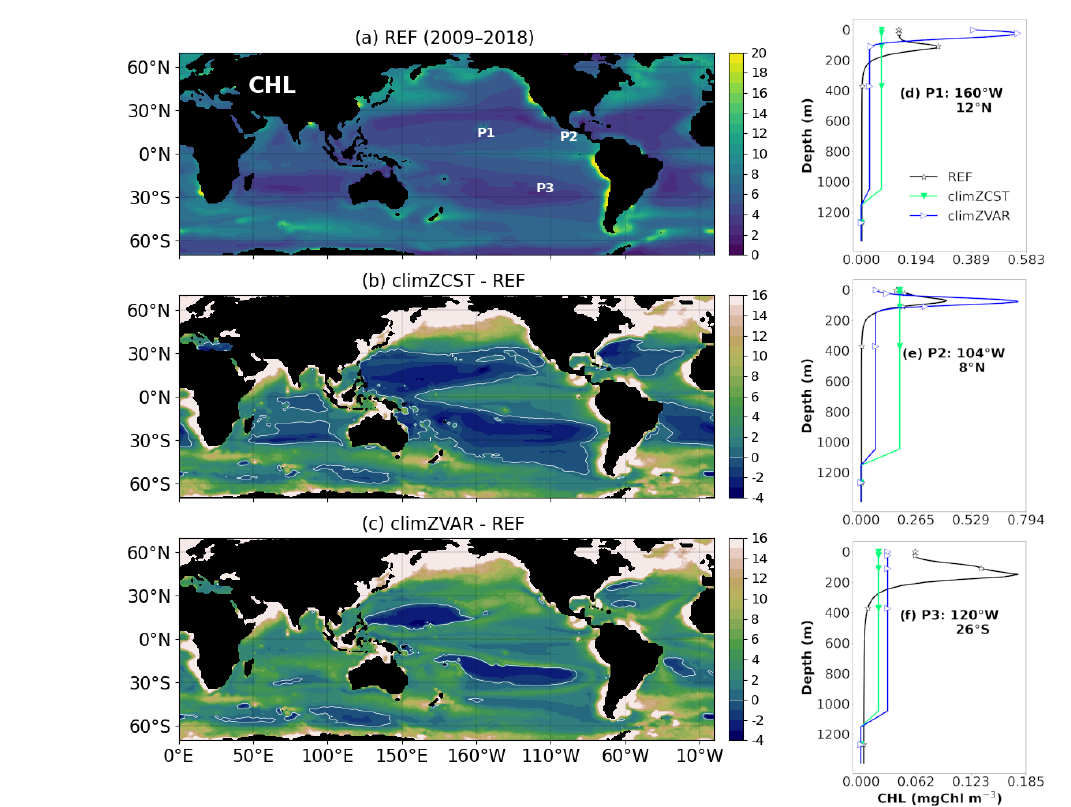
Figure 2. CHL concentration (mgCHLm − 3 ) interacting with the incoming shortwave radiation for each numerical experiment (Table 1). Maps (a–c) show annual means of the vertical sum over 0–6000m, (a) as modelled over the 2009–2018 period for REF, and its differences in relation to the external CHL prescribed for (b) climZCST and (c) climZVAR experiments. Labels P1 to P3 on subplot (a) locate vertical profiles shown on subplots (d–f)